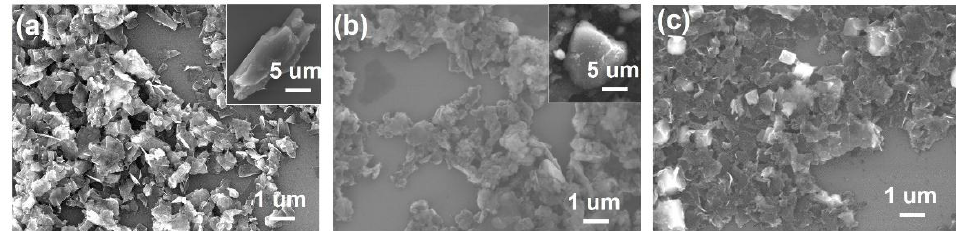
Figure 5. Field emission scanning electron microscopy (FE-SEM) images of exfoliated ( a ) graphene; ( b ) g-C 3 N 4 ; and ( c ) g-C 3 N 4 /graphene composite. The insets in ( a , b ) are SEM images of their bulk counterparts.